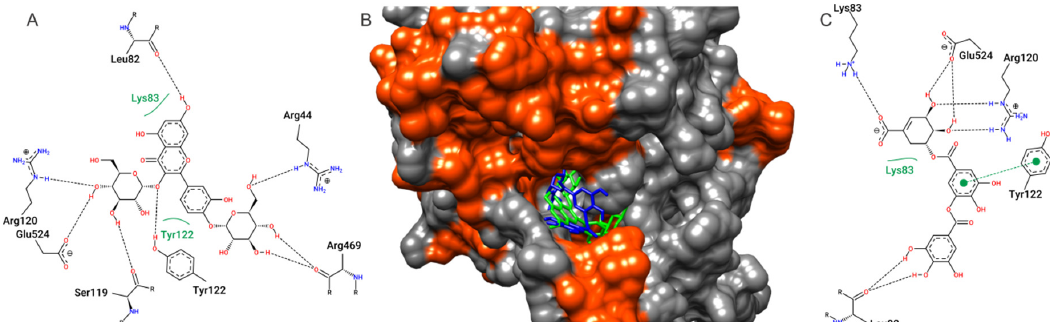
Figure 8. Two-dimensional diagram from contacts of COX-2 active site amino acids residues with quercetin 3,4'-diglucoside ( A ) and digalloylshikimic acid ( C ). Dashed black line—hydrogen bonds; full green lines—van der Waals interactions. In ( B ), the surface representation of quercetin 3,4'-diglucoside (green) and digalloylshikimic acid (blue) docking positions on COX-2 active site are shown.